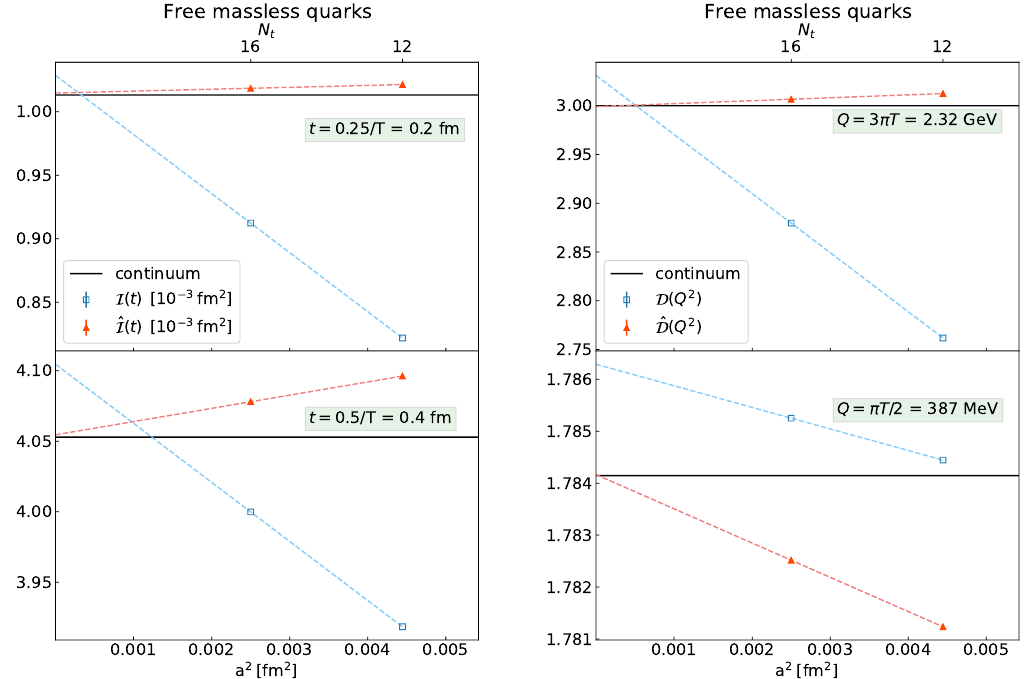
Figure 4 . Continuum extrapolation of the vacuum lattice observables I ( t ) (left) and D ( Q 2 ) (right) and of their improved versions ˆ I ( t ) and ˆ D ( Q 2 ) . The observables are evaluated on two lattices whose lattice spacings a ≈ { 0 . 07 , 0 . 05 } fm are equal to those of the N t = 12 , 16 thermal lattices. The fit ansatz is linear in a 2 . The accuracy of the resulting continuum estimates is reported in table